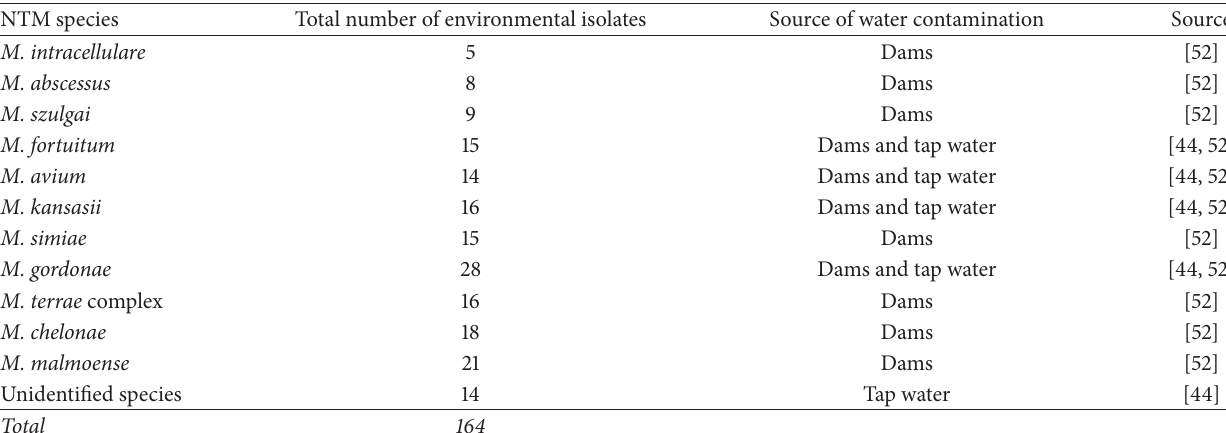
Table 5: Environmental NTM species identified in Saudi